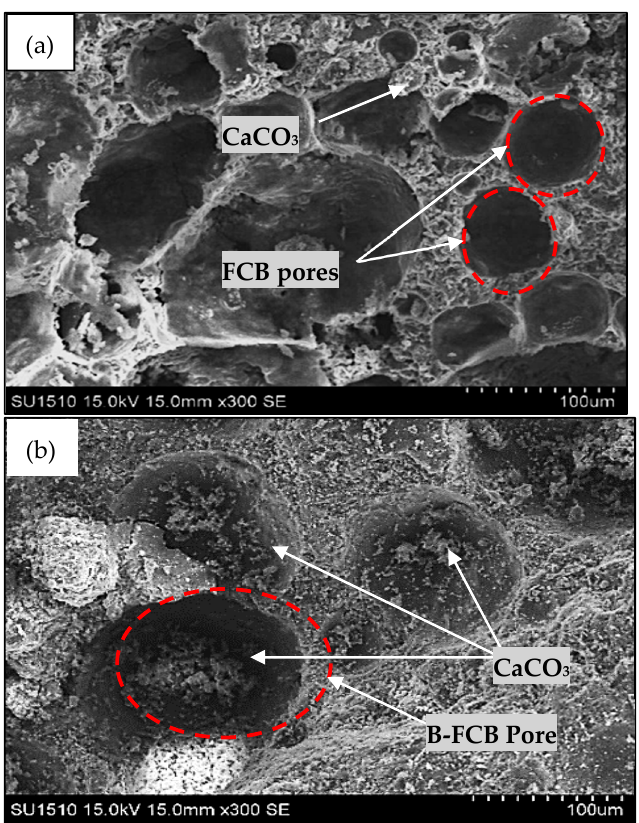
Figure 8. SEM images with specimens with 1300 kg/m 3 density of ( a ) FCB and ( b ) B-FCB at 28 days.